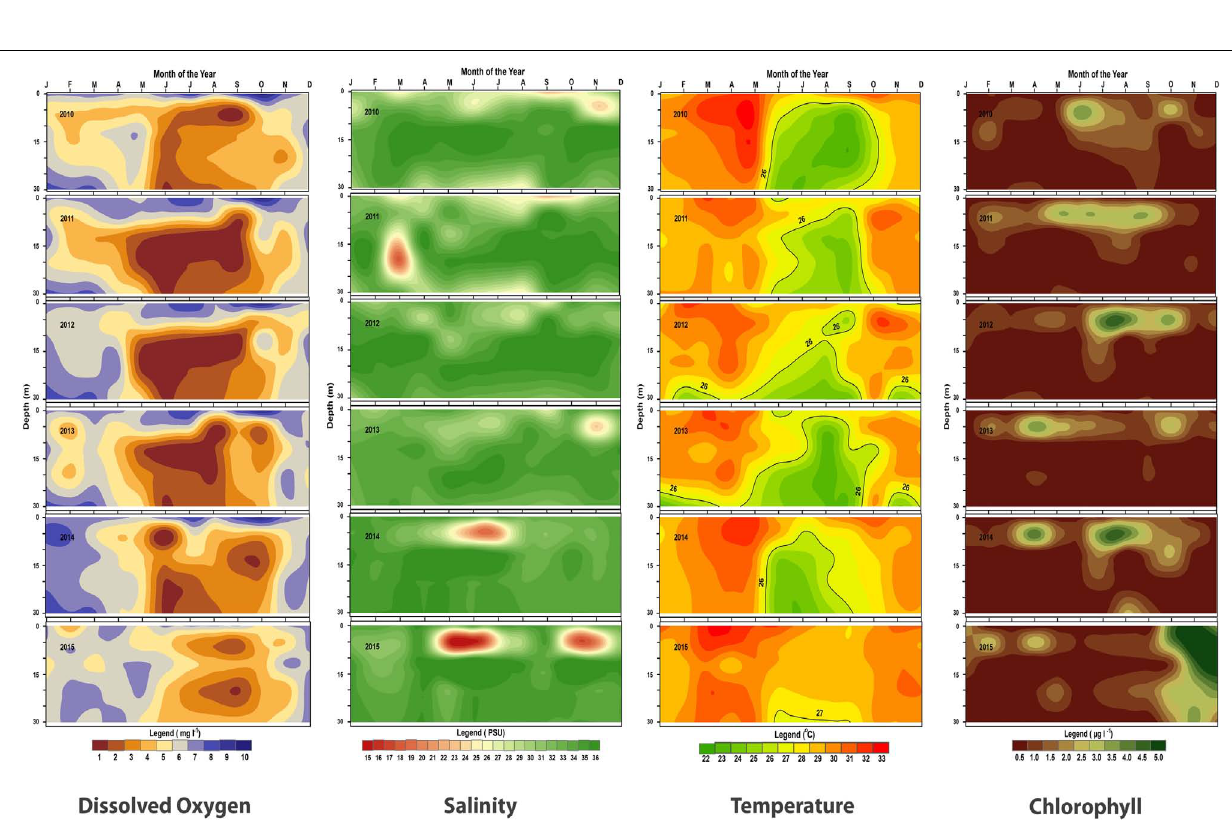
Frontiers in Marine Science |